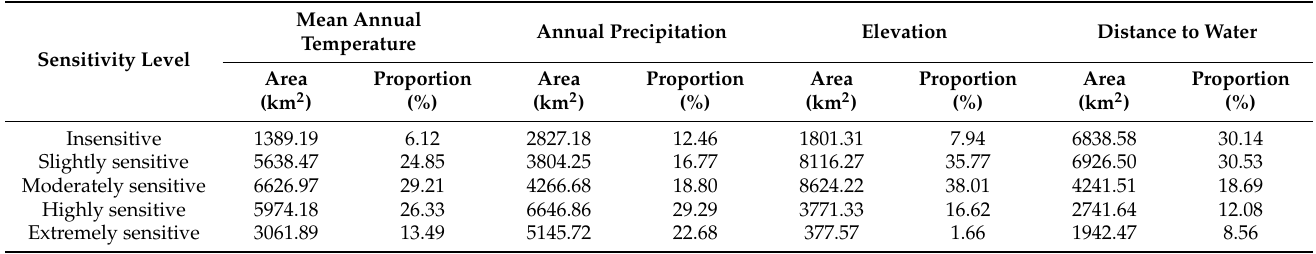
Table 4. Area and proportion of ecological sensitivity classification of the natural environment.